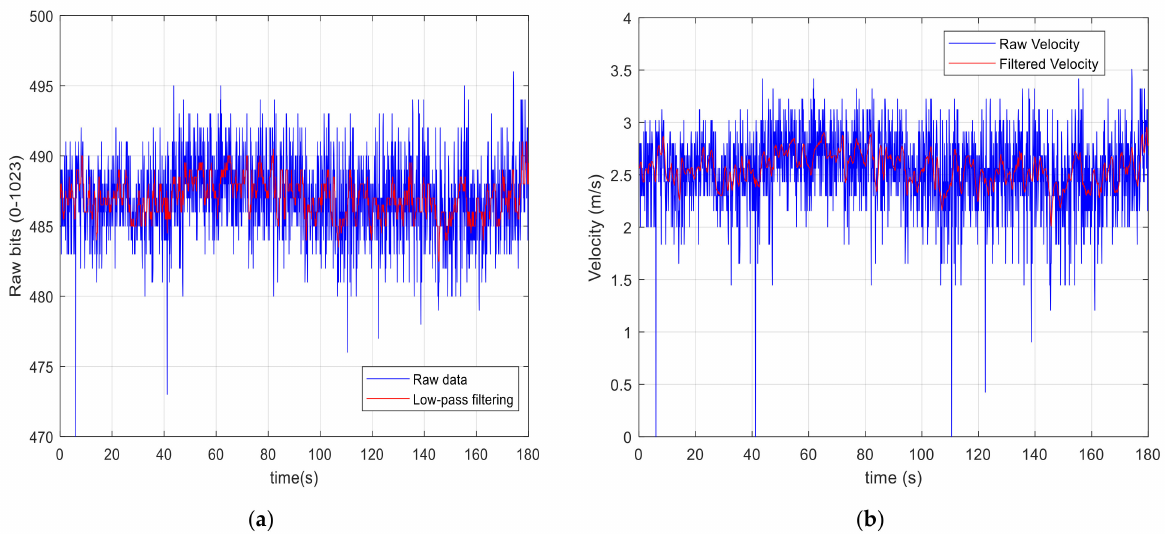
Figure 11. ( a ) Raw data collection during the “Speed 1” test. ( b ) Velocity acquisition (raw data vs. KF data) calculated by Equation (9).